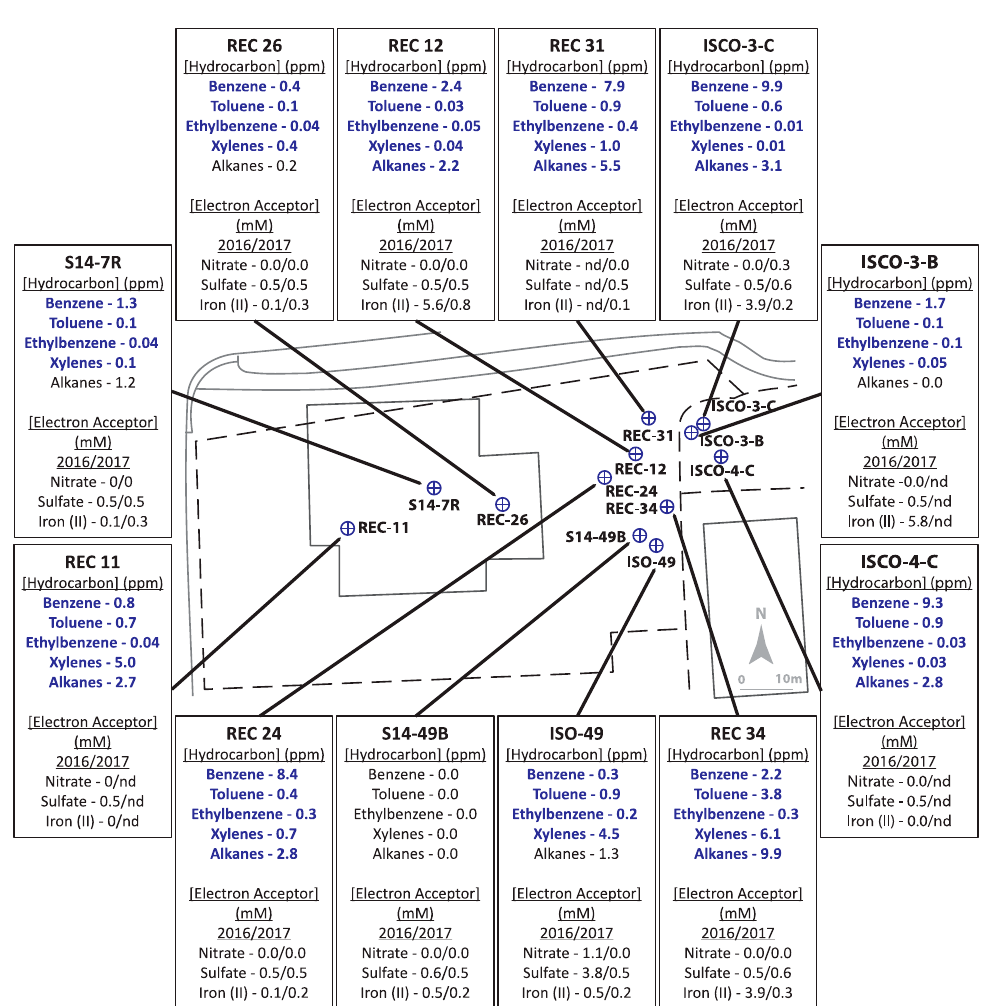
Figure 2. Schematic of Site B, with pop-outs summarizing hydrocarbon concentrations (analyzed in 2016 only) and indicators of potential electron accepting processes (analyzed in 2016 and 2017). Bolded text indicates hydrocarbon concentrations above allowable limits for hydrocarbons in non-drinking groundwater sources. ‘nd’ = no data available as well was not